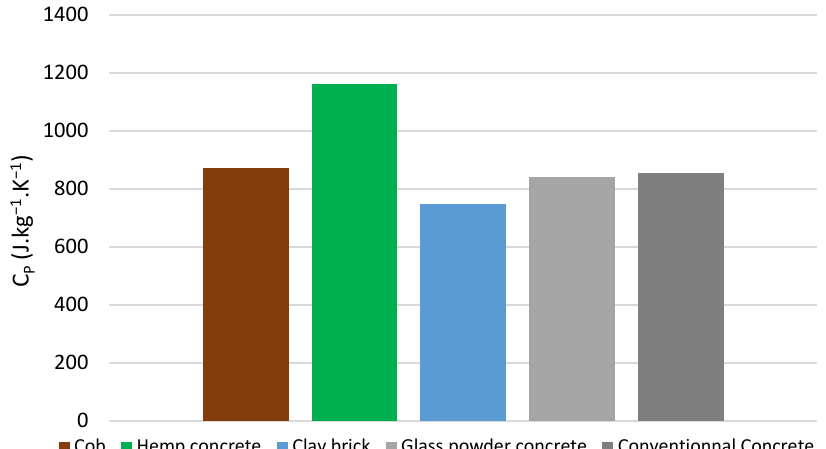
Figure 10. Comparison of cob’s specific heat with different materials.